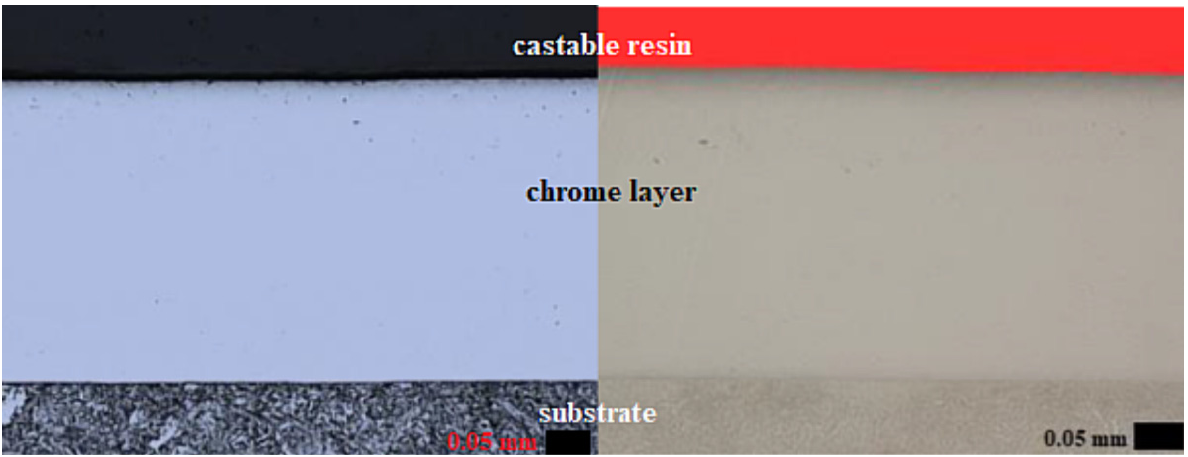
Figure 2. The microstructure and porosity of uncut sample (sample 0).